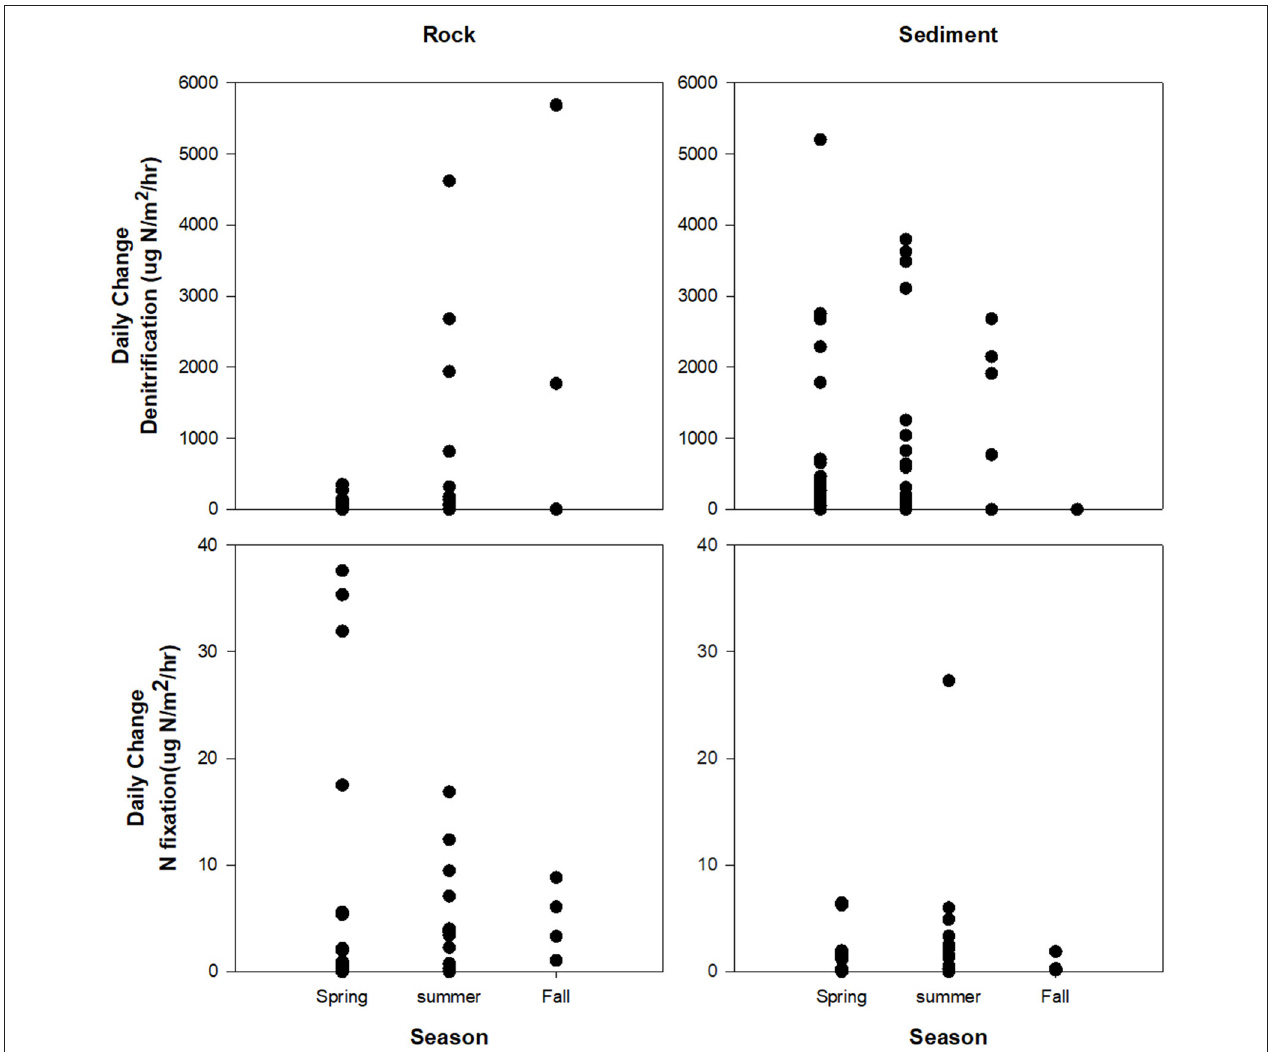
FIGURE 6 | Daily change in denitrification and N 2 fixation in different seasons. Daily change was significantly different between seasons for denitrification on rocks but not for the other rate/substrate